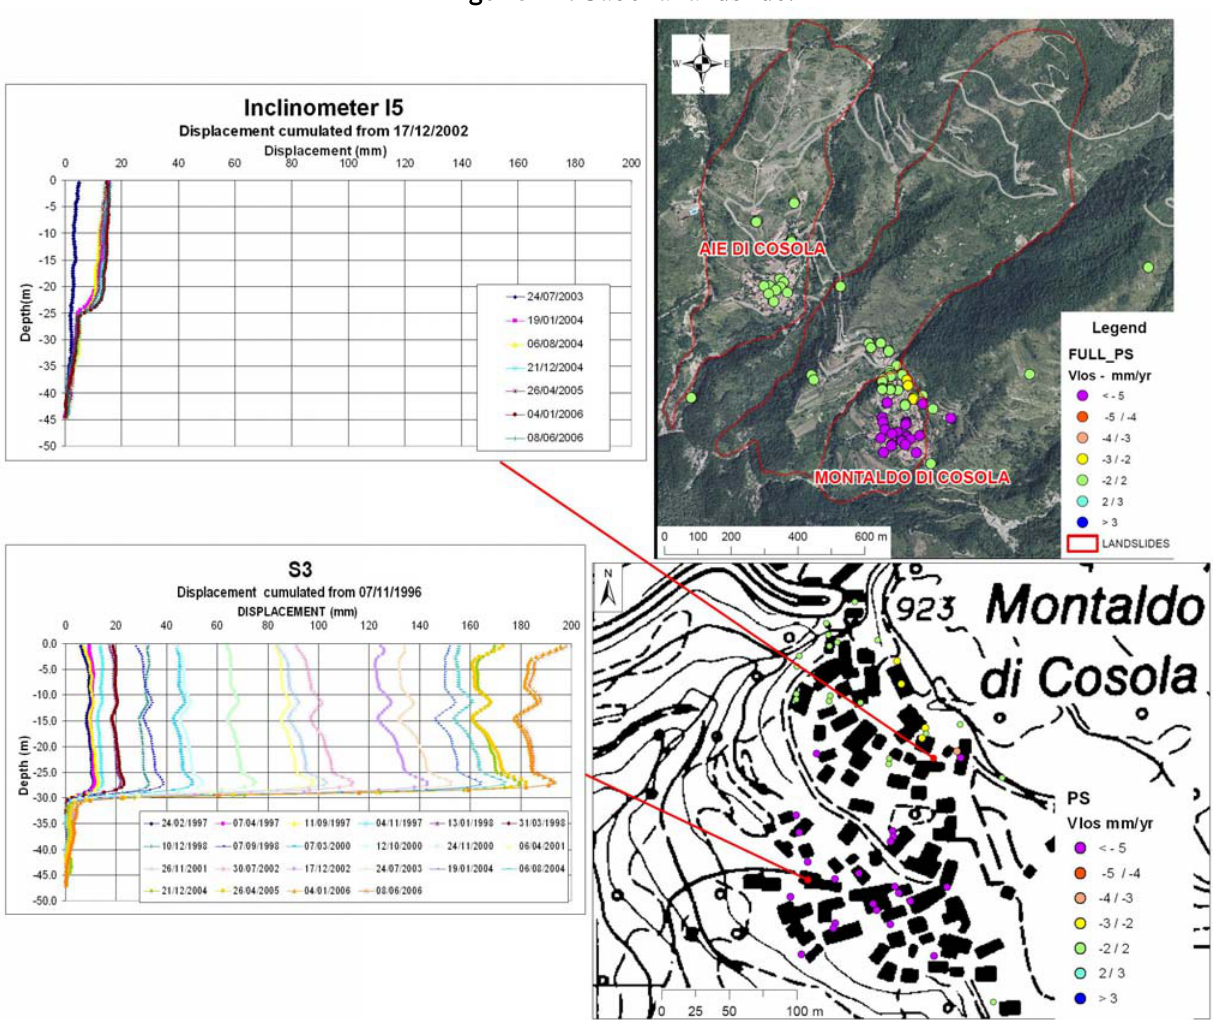
Figure 11. Cabella